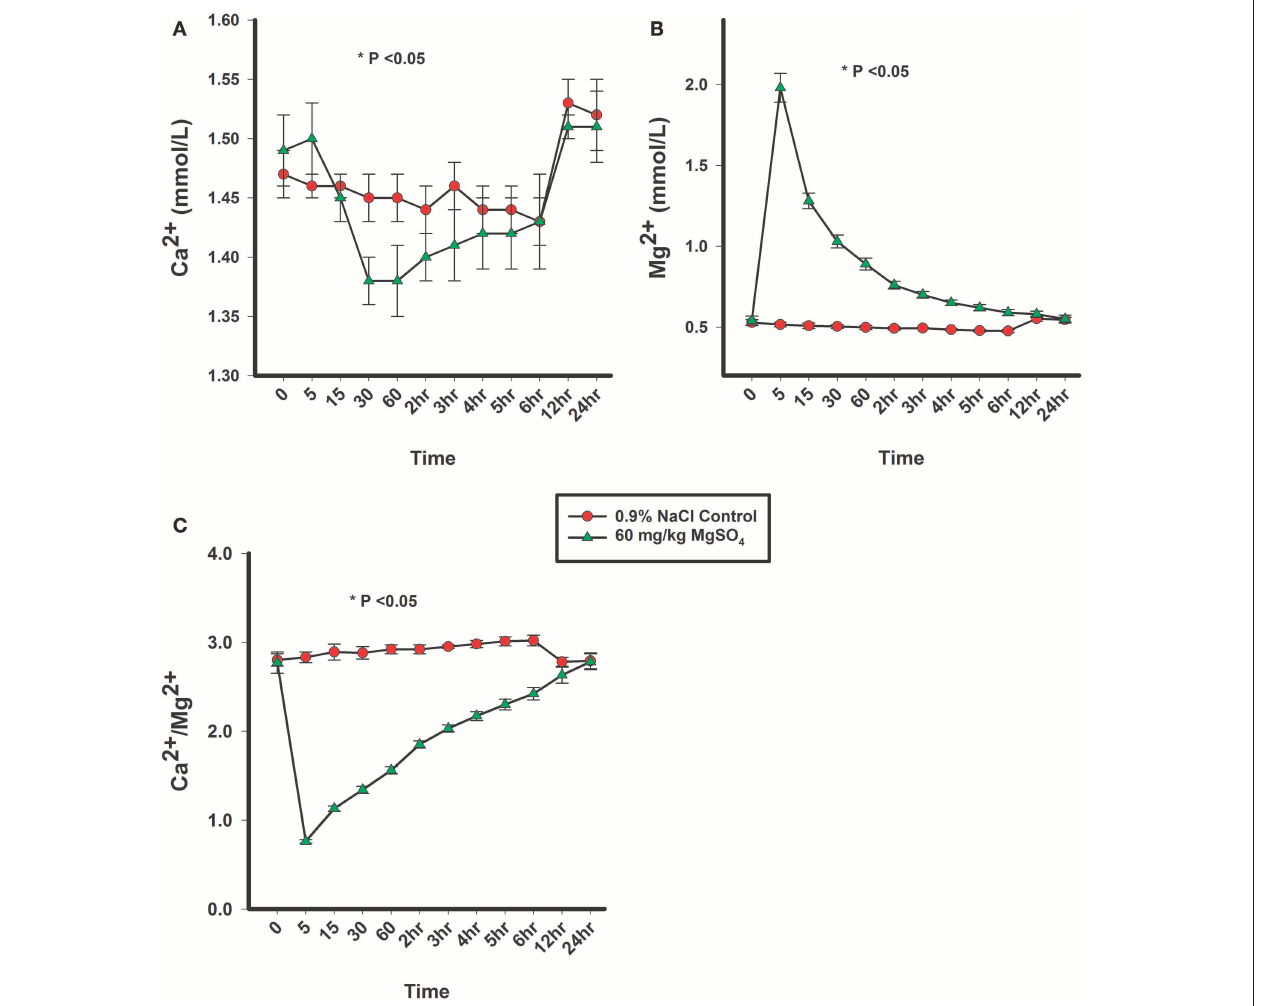
FIGURE 4 | (A) Plasma Ca 2 + concentration, (B) plasma Mg 2 + concentration, and (C) ratio of plasma Ca 2 + to plasma Mg 2 + concentrations from horses administered intravenously 60 mg/kg MgSO 4 (green triangles) and equivalent volume of 0.9% NaCl control horses (red circles). Results are presented as mean ± SE (* P <